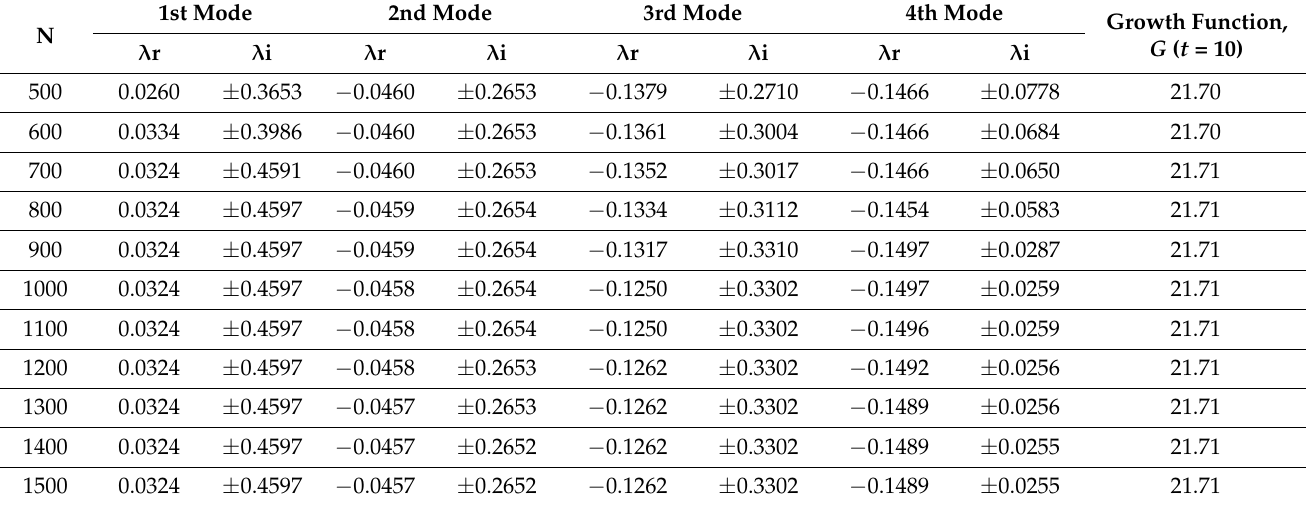
Table 1. Convergence of four least stable eigenvalues belonging to the discrete spectrum for stratified flow α = 0.5, β = 0, Re = 1000, Ri =